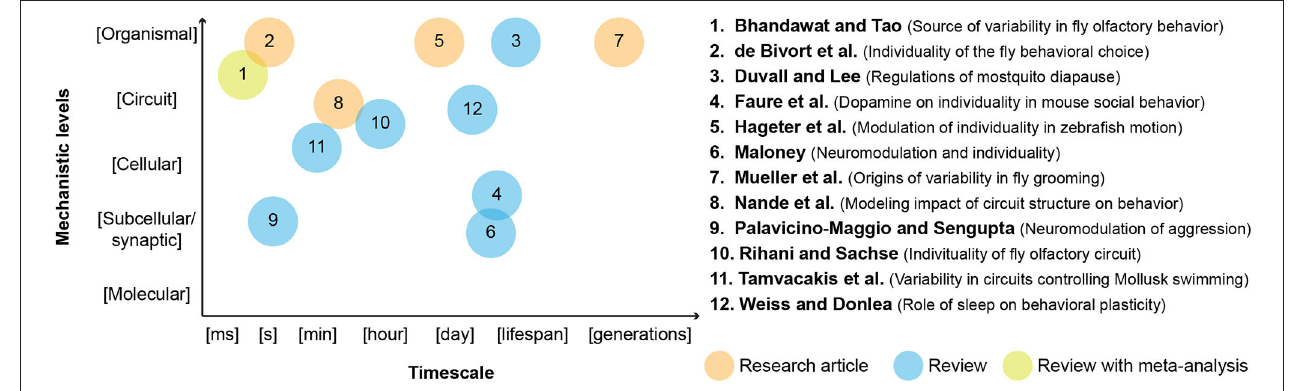
FIGURE 1 | Mapping the scope of articles in this Research Topic. Numbers are given according to the alphabetical order of the first